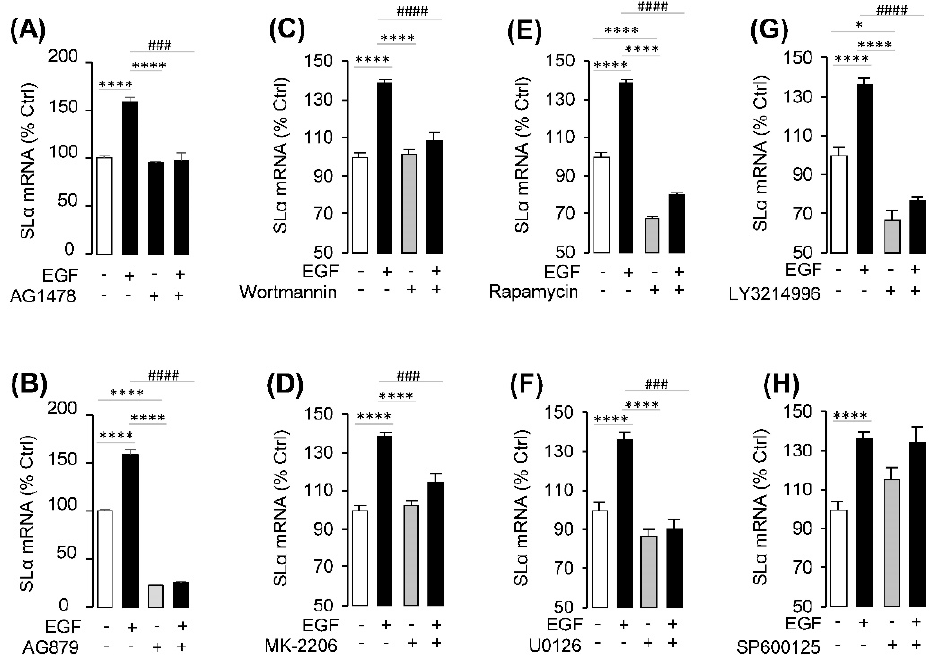
Figure 3. Receptor specificity and post receptor signal pathway of EGF-induced SL α mRNA expression in grass carp pituitary cells. ( A , B ) Effects of ErbB1 antagonist AG1478 and ErbB2 antagonist AG879 on EGF-induced SL α mRNA expression, respectively. Grass carp pituitary cells were treated for 24 h with EGF (10 nM) in the presence or absence of AG1478 (5 µ M) or AG879 (5 µ M). ( C – E ) Effects of 24-h co-treatment with the PI3K inhibitor wortmannin (1 µ M), Akt inhibitor MK-2206 (10 µ M) and mTOR inhibitor rapmycin (20 nM) on EGF (10 nM)-induced SL α mRNA expression, respectively. ( F – H ) Effects of 24-h co-treatment with the MEK inhibitor U0126 (10 µ M), ERK inhibitor LY3214996 (10 µ M) or JNK inhibitor SP600125 (10 µ M) on EGF (10 nM)-induced SL α mRNA expression, respectively. After drug treatment, total RNA was isolated for real-time PCR of SL α . In these experiments, the two-way ANOVA was used to test the significant differences among various groups. The asterisk was used to reveal the significant difference between the EGF- or each signal pathway inhibitor-treated group, and the control group (* p < 0.05; ** p < 0.01; *** p < 0.001; **** p < 0.0001). The octothorpe was used to present the significant difference among the EGF-treated group, signal pathway inhibitor-treated group and EGF + signal pathway inhibitor-treated group (# p < 0.05; ## p < 0.01; ### p < 0.001; #### p <